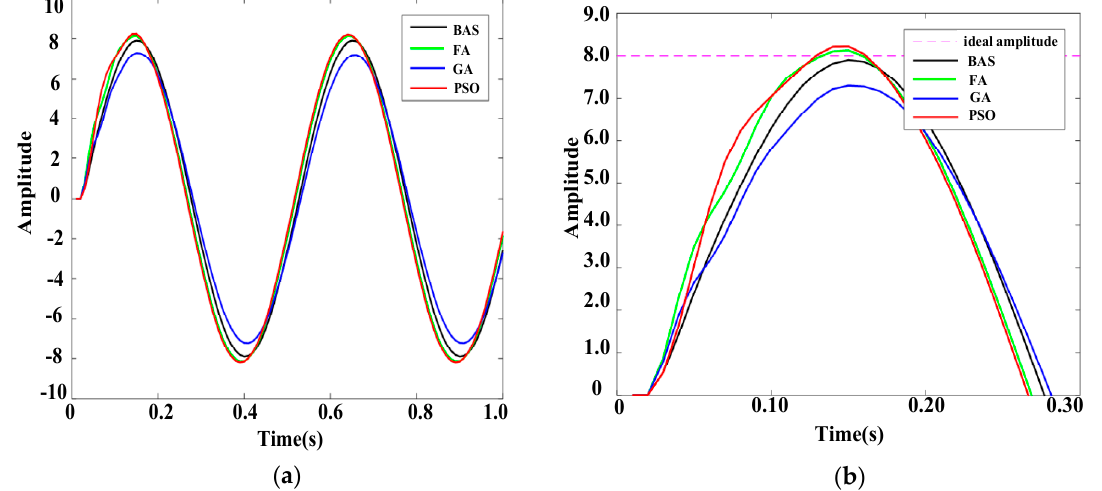
Figure 13. Response curves of the sinusoidal signal whose amplitude is 8. ( a ) Whole response curves. ( b ) Local amplification curves.